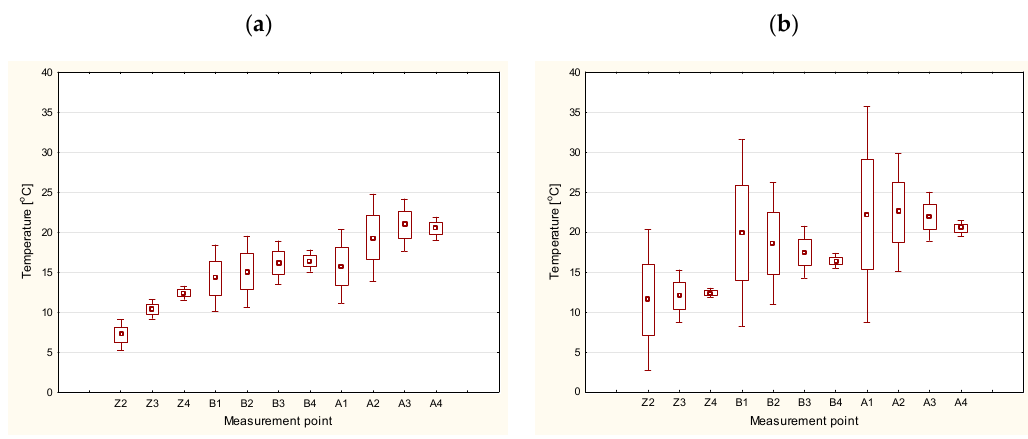
Figure 5. Soil temperatures in measurement points located in the soil surrounding the building: ( a ) winter and ( b ) summer.